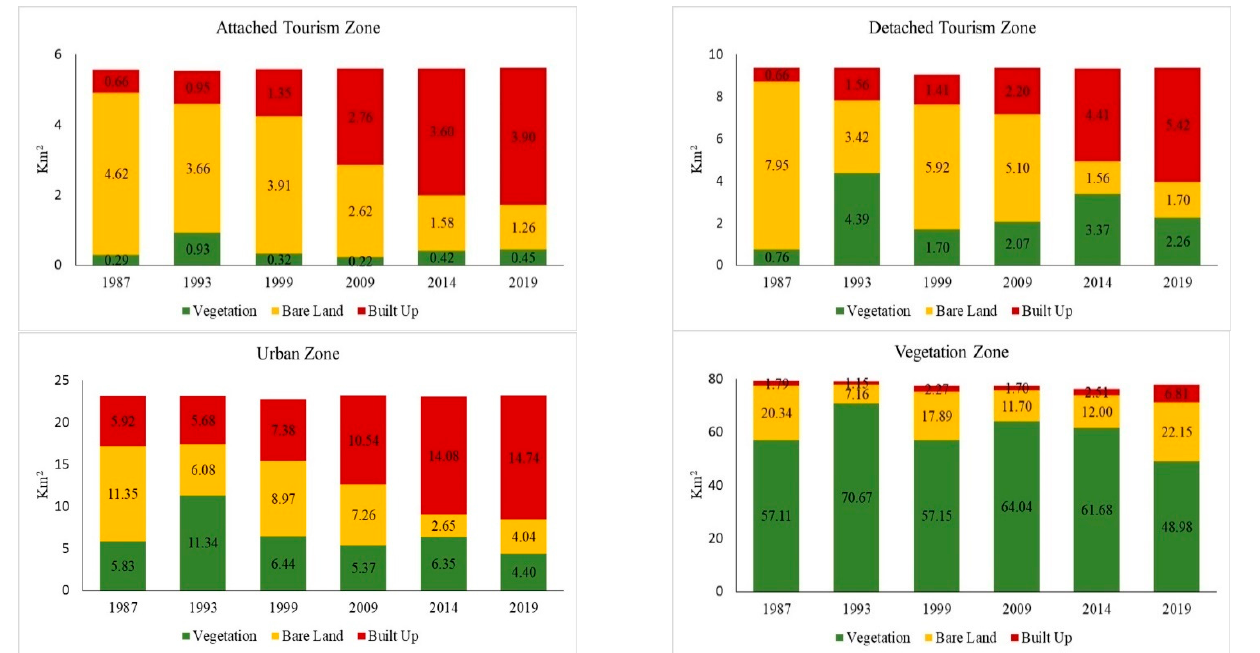
Figure 9. Land use changes in the main zones of the study area during the years 1987 to 2019 (km 2 ).